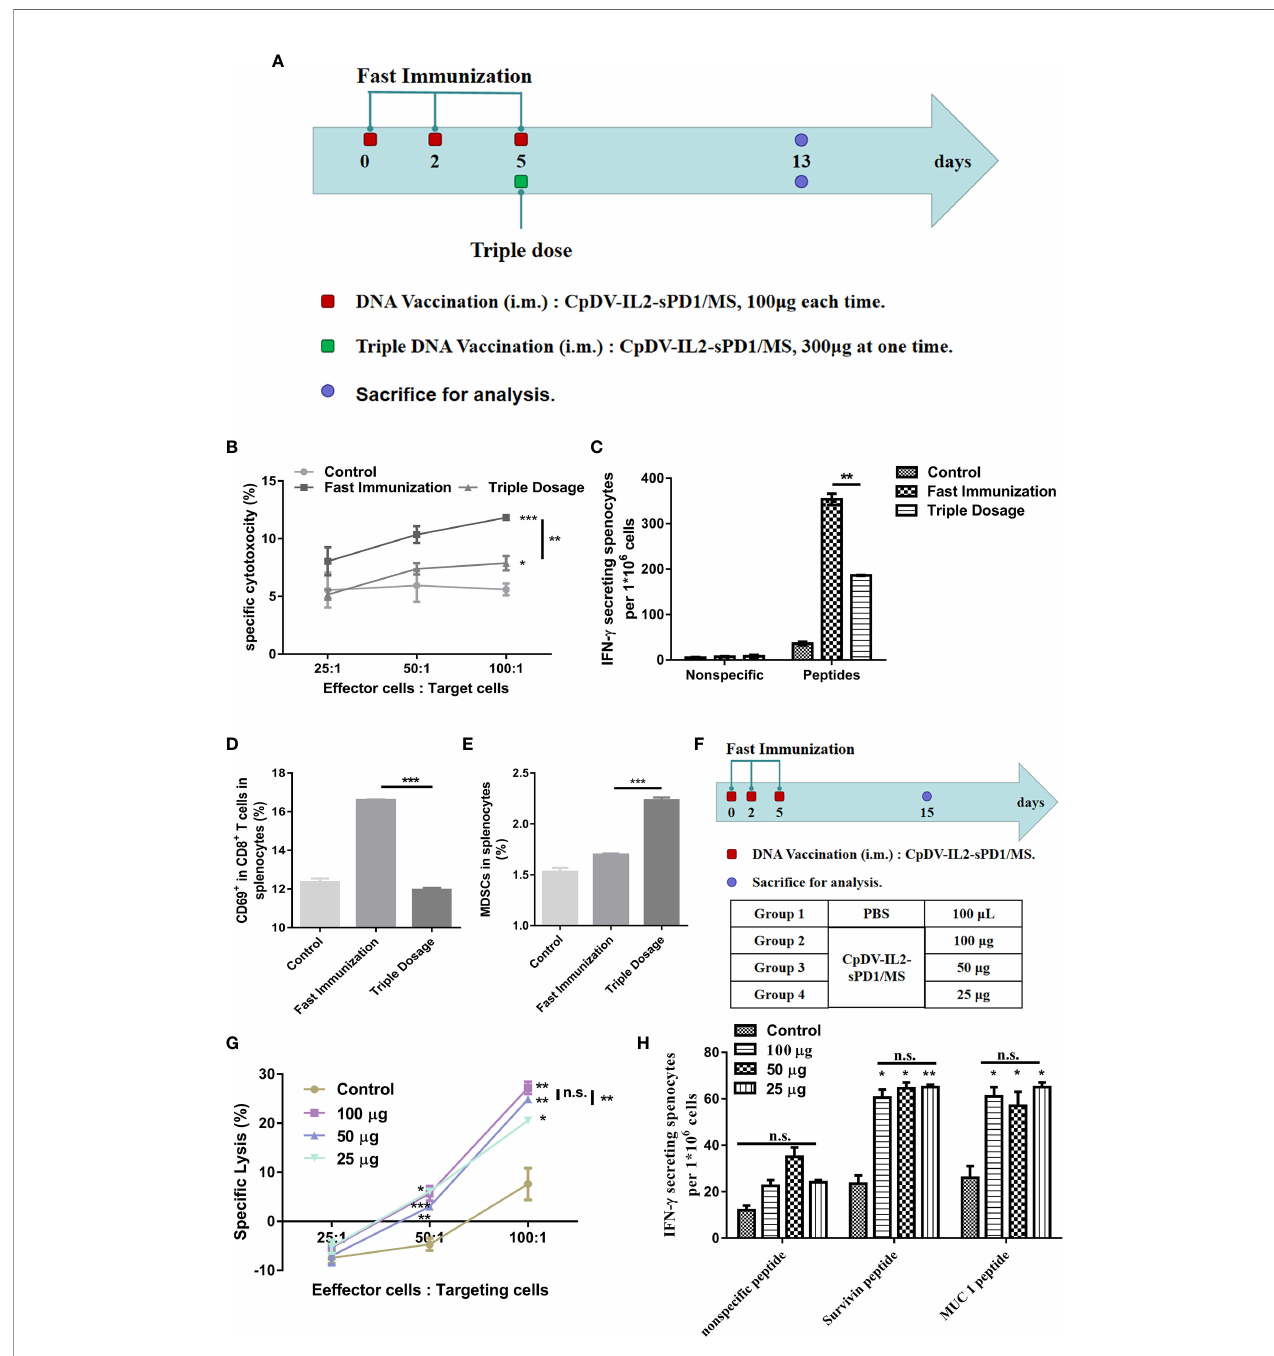
FIGURE 4 | Ef fi cacy of DNA vaccine dosage in the fast immunization strategy. (A) Immunization regimen. In the fast immunization group, BALB/c mice (n = 5) were vaccinated with 100 m g DNA vaccine on days 0, 2, and 5. In the triple-dosage group, mice were vaccinated with 300 m g DNA vaccine (150 m g in each thigh muscle) once on day 5. All mice were sacri fi ced on day 13. The splenocytes were separated and analyzed. (B) Cytotoxic T lymphocyte (CTL) assay. The E/T ratio was 25:1, 50:1, and 100:1, respectively. (C) ELISpot assay. Splenocytes were stimulated with peptides (survivin H2-K d sequence: AFLSVKKQF, fi nal concentration: 10 m g/ml; MUC1 H2-K d sequence: APDTRPAPG, fi nal concentration: 10 m g/ml). (D) Activation of CD8 + T cells. The percentage of CD69 + -PE cells was determined by fl ow cytometry (FACS) with gating for CD3 + FITC/CD8 + antigen-presenting cells. (E) Myeloid-derived suppressor cells (MDSCs) in lymphocytes. The percentage of MDSCs, CD11b- PE/Gr-1 APC/Ly-6G FITC, was detected using FACS. (F) Twenty BALB/c mice (n = 5) were divided into four groups. Vaccine doses included 25, 50, and 100 m g at each time point in the respective treatment group. The vaccination and intervals were as for the fast immunization strategy in (A) . (G) CTL assay. (H) ELISpot assay. (* p < 0.05, ** p < 0.01, *** p < 0.001, n.s., p >